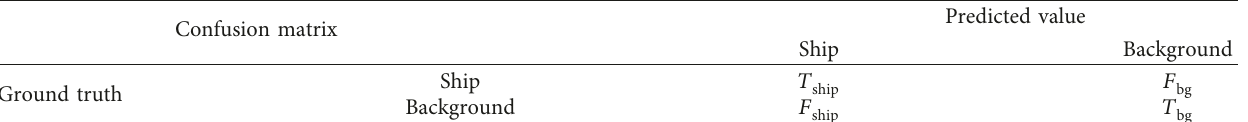
Table 6: Confusion matrix of ship target